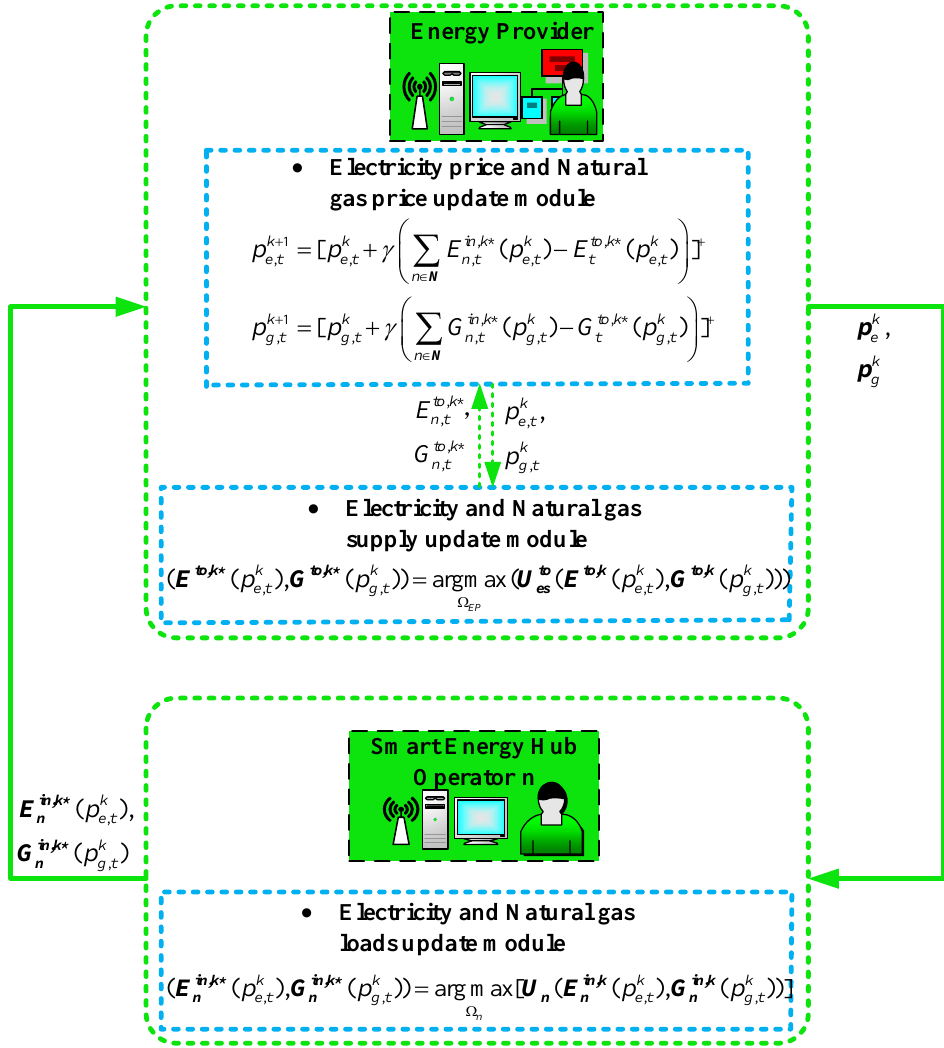
Figure 3. Interactions between the energy provider and smart energy hubs.